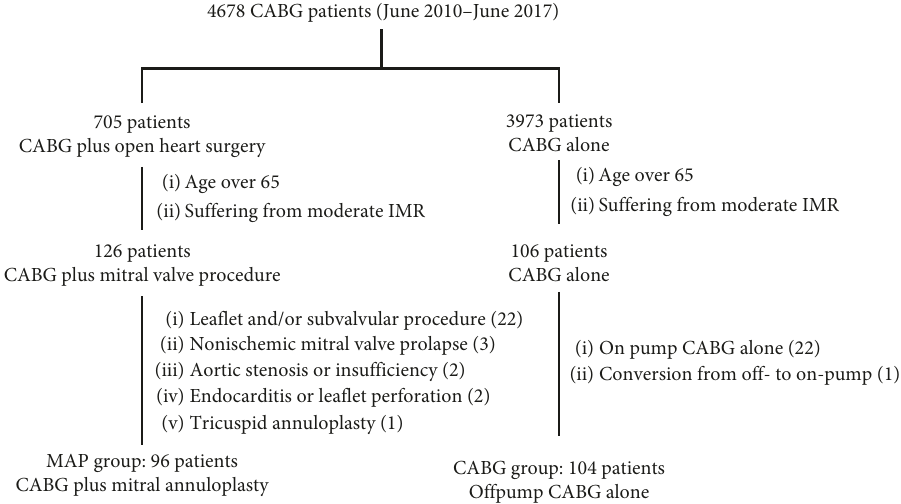
Figure 1: Flowchart of selected patients. CABG, coronary artery bypass grafting; MAP, mitral